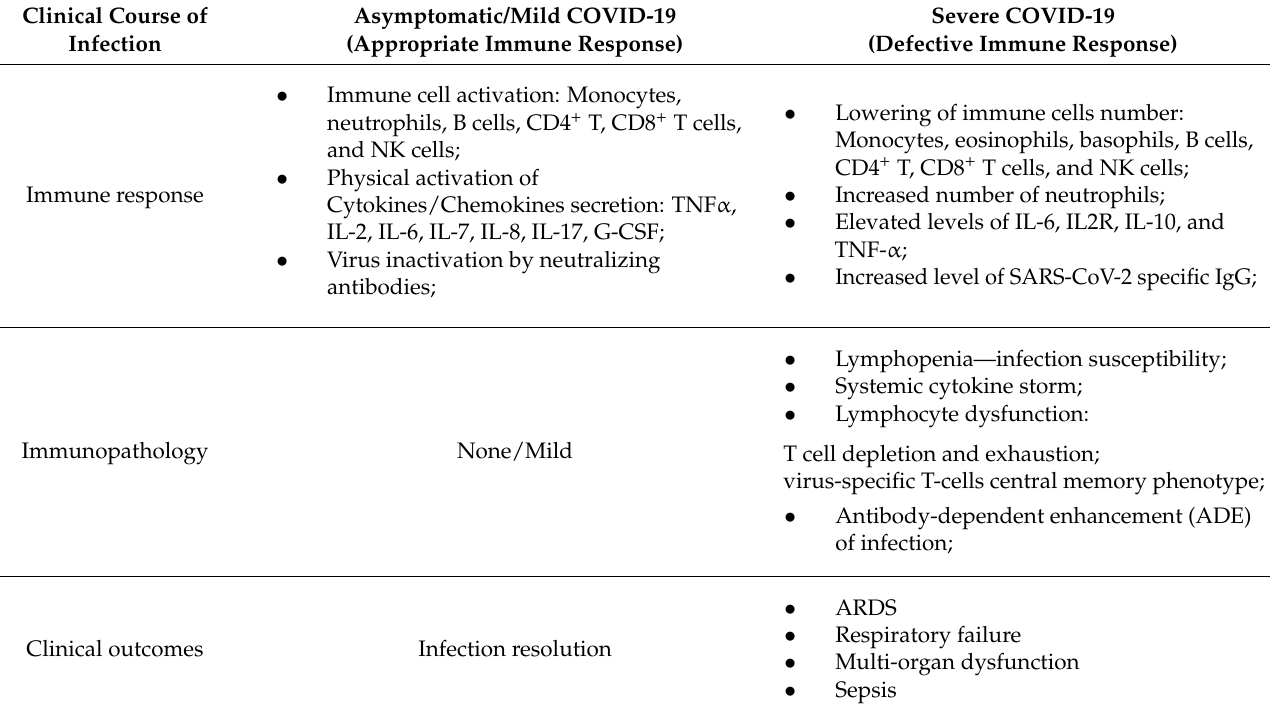
Table 1. Immune characteristics related to the clinical course of SARS-CoV-2